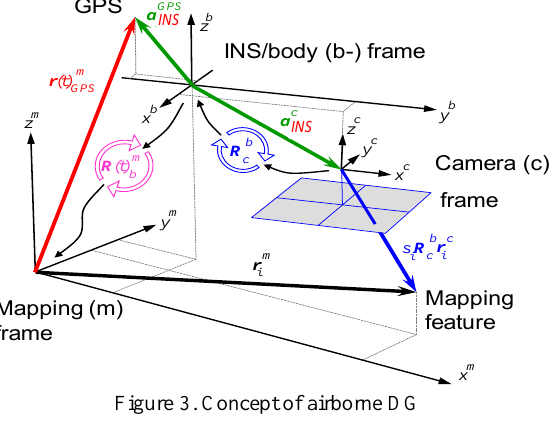
Figure 3. Concept of airborne